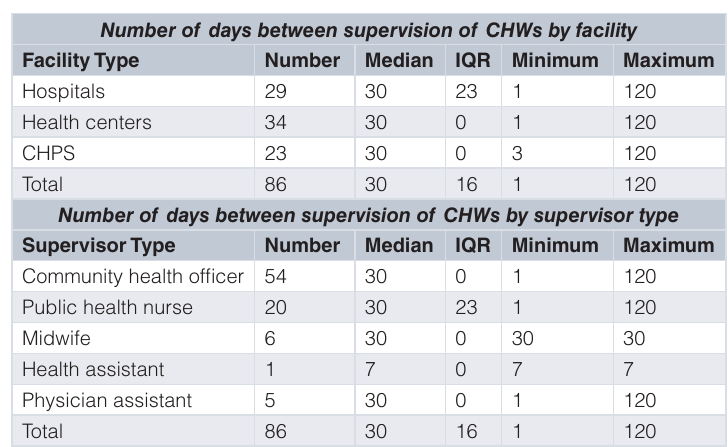
Table 7. Frequency of community health worker (CHW) supervision interactions by facility and supervisor types.